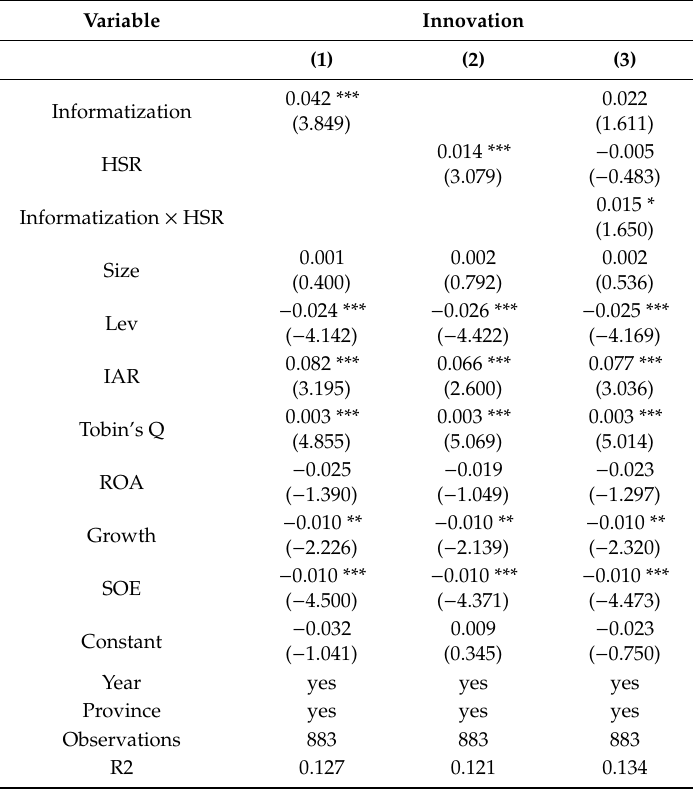
Table 3. Regression analysis